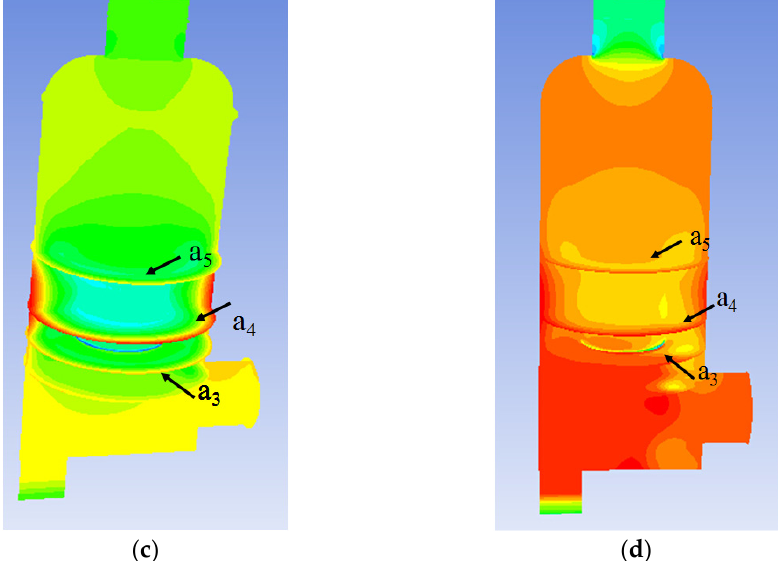
Figure 8. The static pressure drop in the packing zone. ( a ) Plane a 3 to a 4 ; ( b ) plane a 4 to a 5 ; ( c ) gas flow rate 200 m 3 h − 1 ,